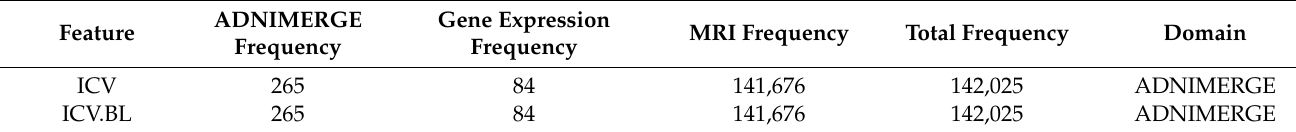
Table 5. Example of Features with Identical Results but Slightly Different